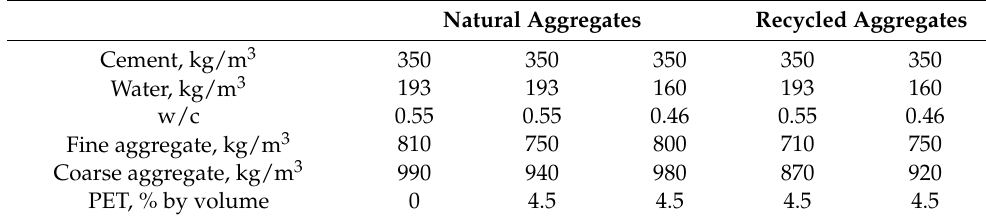
Table 1. Typical concrete mix design